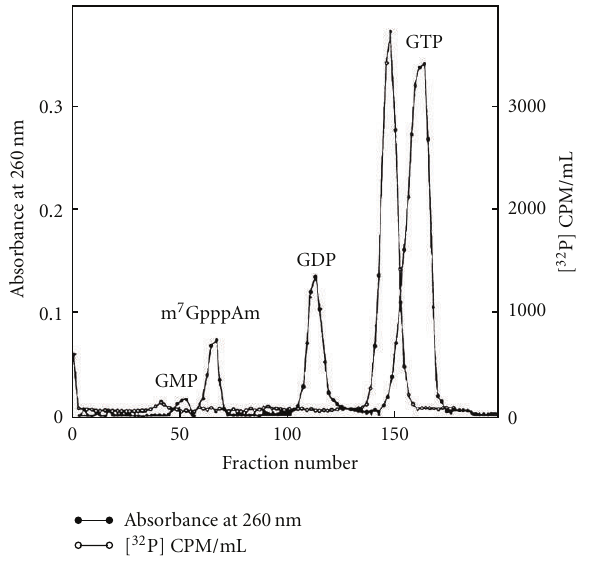
Figure 21: DEAE column chromatography of U1 5 (cid:2) oligonucleo- tide [16]. Spot “a” in Figure 20 was eluted and digested with alkaline phosphatase. The product was chromatographed on DEAE-Sepha- dex A-25 with GMP, GDP, and GTP. The fragment chromato- graphed at GTP region.